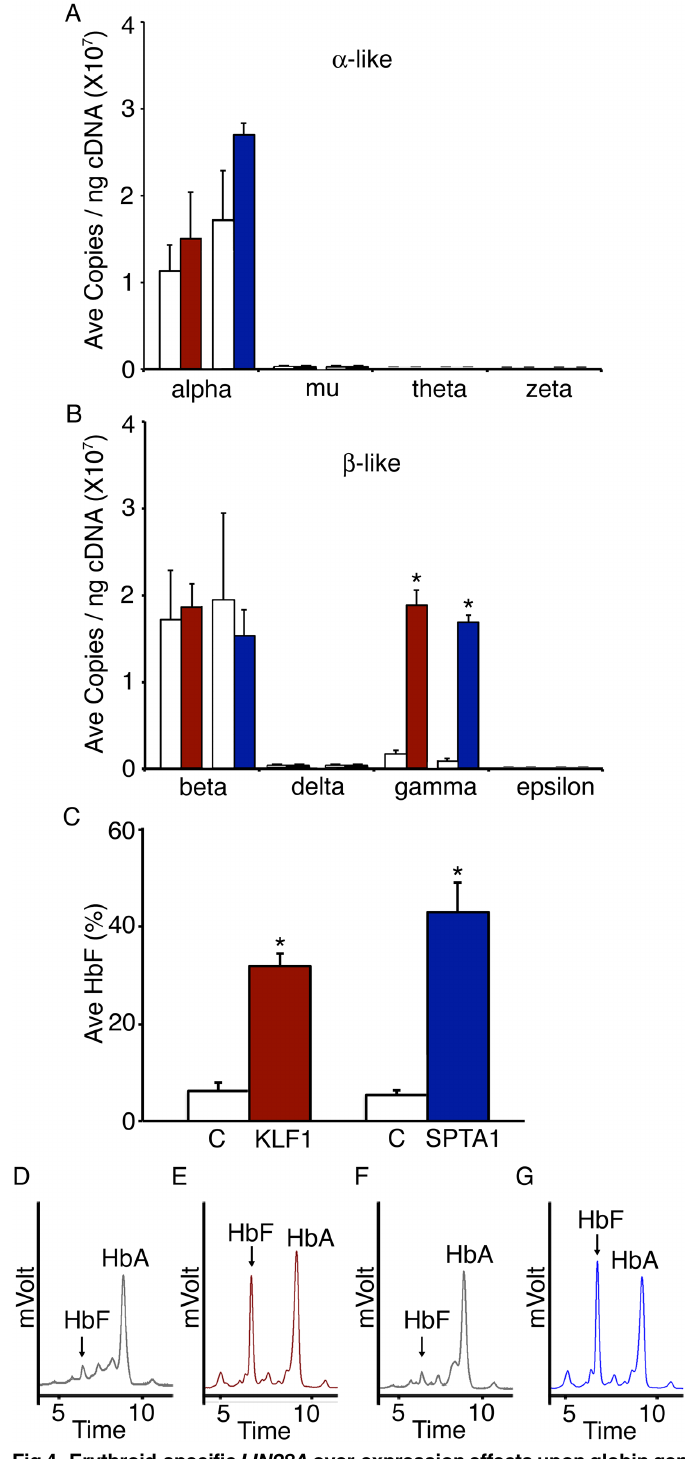
Fig 4. Erythroid-specific LIN28A over-expression effects upon globin gene and protein levels in cultured adult erythroblasts. LIN28A over-expression driven by KLF1 or SPTA1 promoter compared to control samples in the mRNA expression levels of (A) alpha -, mu -, theta - and zeta - globins and (B) beta -, delta -, gamma - and epsilon - globins . Analyses were performed at culture day 14. (C) HPLC analysis of hemoglobin from each respective control, KLF1-LIN28A-OE, and SPTA1-LIN28A-OE erythroblasts at